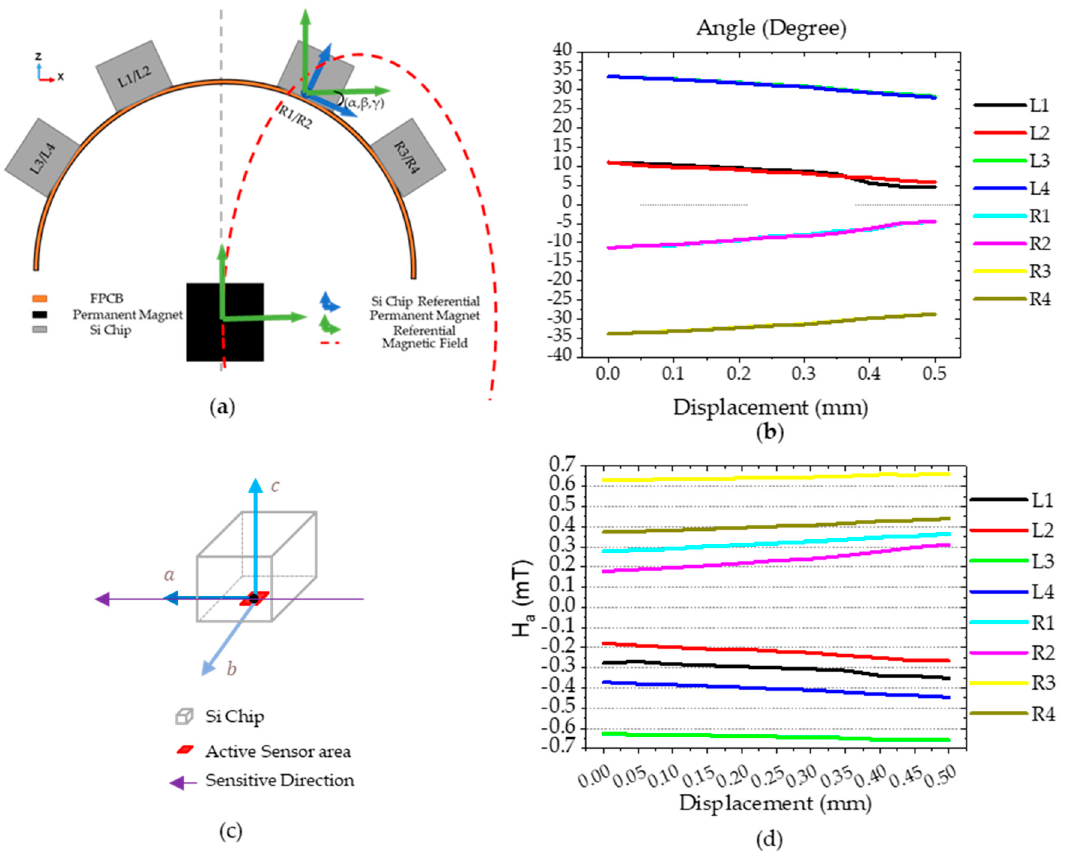
Figure 17. ( a ) XZ plane schematics showing the relationship between the Si chip (blue) and permanent magnet (green) reference frame; ( b ) angle α simulated and taken from the mechanical simulation for each Si chip, in this case both β and γ are 0. ( c ) abc referential centered on the spin valve active area, which coincides with the Si chip’s surface. ( d ) The magnetic field magnitude on the active area of the sensor.